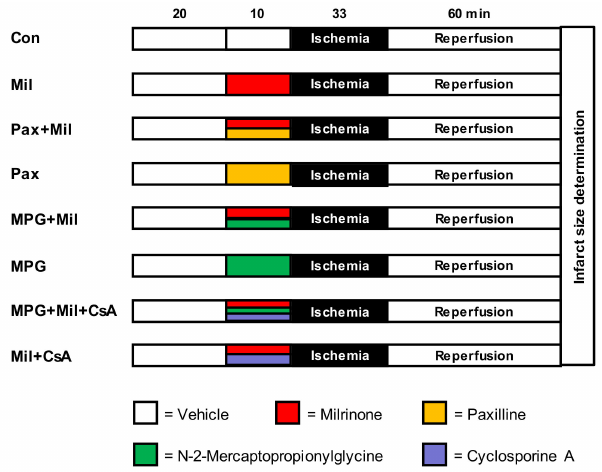
Figure 2. Experimental scheme from part two of the study: Con = Control; Mil = Milrinone; Pax = Paxilline; MPG = N-2-mercaptopropionylglycine; CsA = Cyclosporine A.